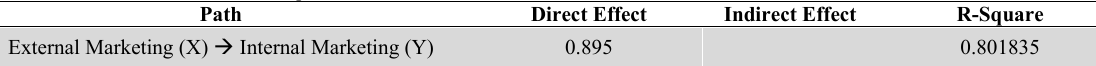
Table 3 Direct Effect, Indirect Effect, and R-Square Path Direct Effect Indirect Effect R-Square External Marketing (X)  Internal Marketing (Y) 0.895 0.801835